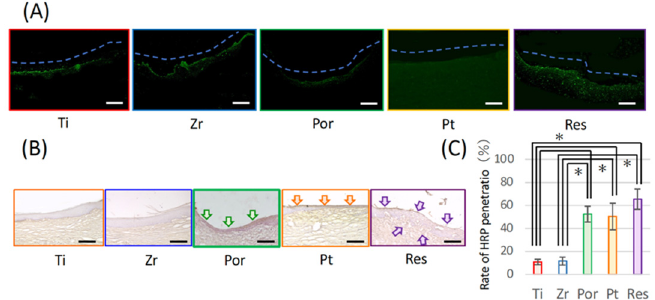
Figure 7. Image of the oral mucosa in contact with the base of bridge pontics built from the five materials. ( A ) Image of fluorescent immunostaining with laminin-332. Bar = 100 μ m. ( B ) Light microscope image of chemically stained horseradish peroxidase (HRP) in each group. Bar = 150 µ m. ( C ) Graph illustrating the rate at which HRP penetrated the center of the base of the pontic. Each bar represents the mean ± SD. One-way ANOVA with Scheffe’s post-hoc test; * p < 0.05 between the indicated groups.